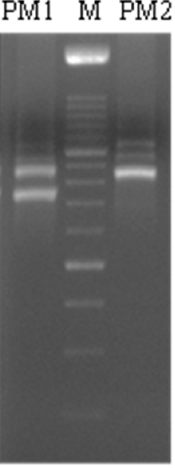
Figure 1. Agarose gel electrophoresis of 16S–23S Proteus Internal Transcribed Spacer (ITS) region amplification showing the banding patterns of PM1 and PM2.